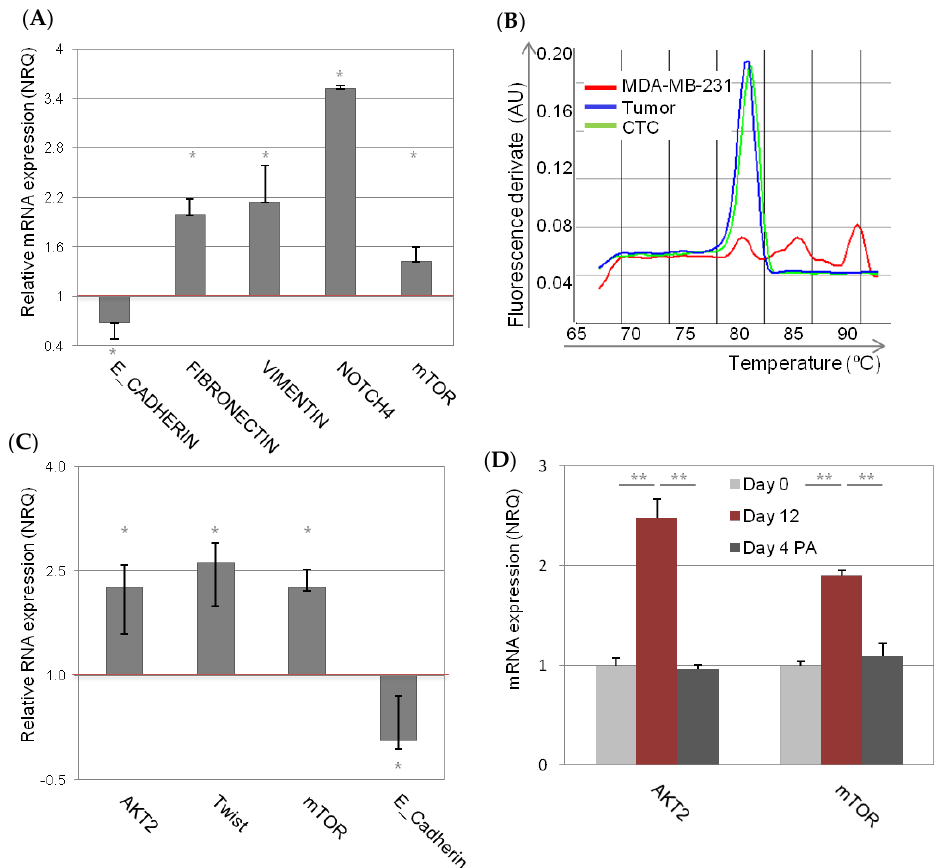
Figure 5. AKT2 / TWIST / mTOR axis in vivo and in vitro. Gene expression in the tumors derived from non-CSC relative to tumors derived from CSC-like tdTomato + cells ( A ). Dissociation curve plot confirmed that tumors expressed TWIST , even though the injected cells did not express TWIST per se ( B ). Gene expression in circulating tumor cells (CTCs) isolated from the blood of tumor bearing animals relative to gene expression of tumors ( C ). Gene expression in low attachment culture conditions, relative to the same cells cultured in monolayer ( D ). qPCR results are expressed as NRQ (relative normalized quantities) mean ± SEM ( n ≥ 3); (* p < 0.05; ** p < 0.01).